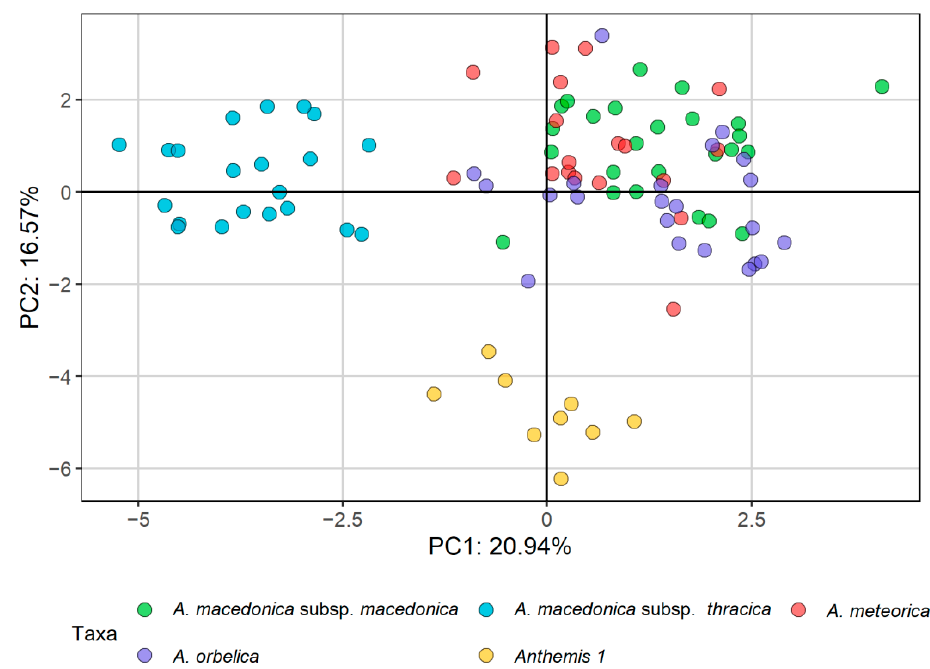
Figure 1. Principal component analysis (PCA) of the Anthemis macedonica group, based on 20 quantitative characters and three ratios.